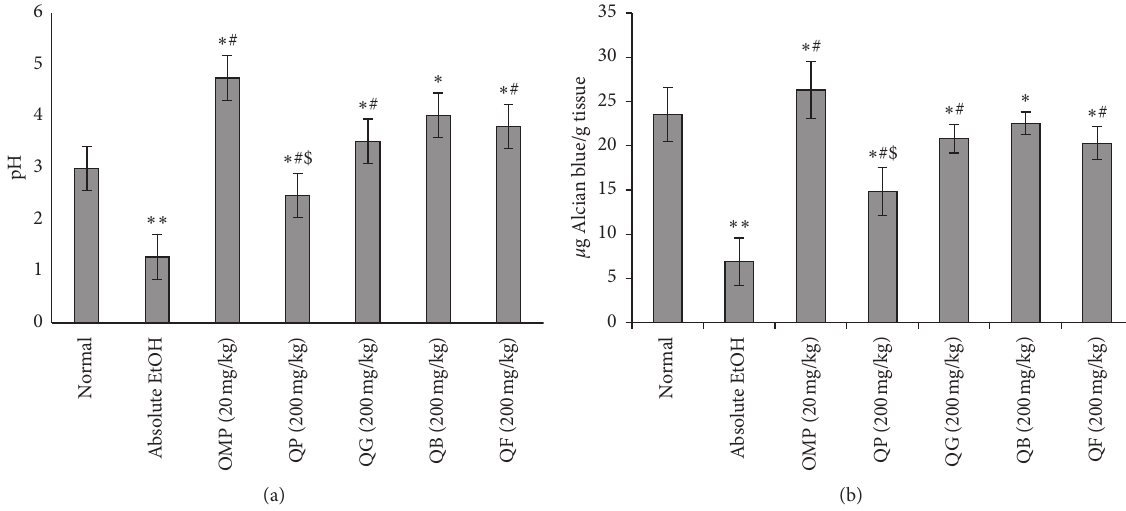
Figure 5: Effect of oral doses of 200mg/kg of QP (quinoa seeds cooked under high pressure), QG (first stage-germinated quinoa seeds), QB (quinoa seeds fermented by Lactobacillus plantarum bacteria), and QF (quinoa seeds fermented by Rhizopus oligosporus fungus) on the (a) gastric pH and (b) gastric wall mucus (GWM) in absolute EtOH-induced (5mL/kg) acute gastric injury in rats and in comparison with the reference drug omeprazole (OMP, 20mg/kg). ∗∗ p < 0 . 05 compared to normal. ∗ p < 0 . 05 compared to absolute EtOH. # p < 0 . 05 compared to omeprazole OMP. $ p < 0 . 05 compared to QB. Table 2: Effect of oral administration of the four types of processed quinoa seeds (QP, QG, QB, and QF) on the gastric protein content of MDA, SOD, CAT, GPx, and PGE 2 . Treatment Normal Absolute